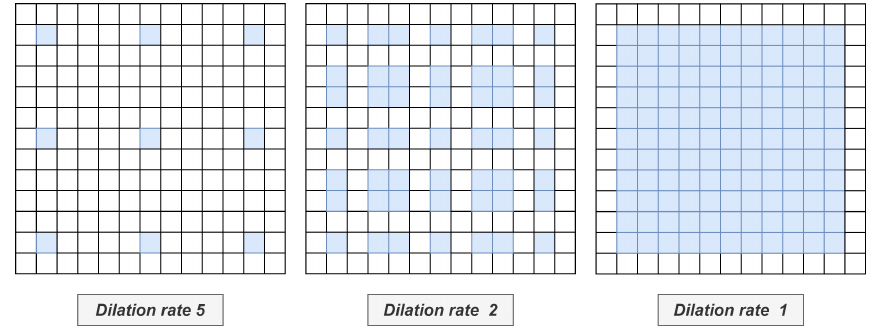
Figure 3. Illustration of the hybrid dilated convolution (HDC) framework. Left to right, convolutional layers have dilation rates of r = 5, 2, 1, respectively.